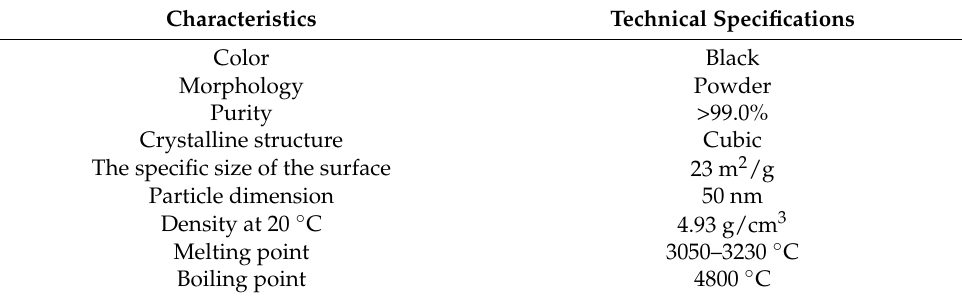
Table 2. The characteristics of TiC